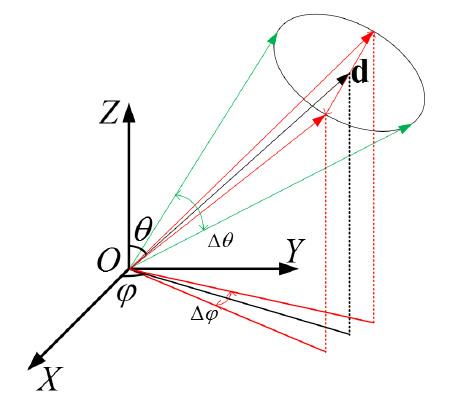
Figure 3. The variation of line direction with the fluctuation of θ and φ . The fluctuation ∆ θ is added to θ and ∆ φ is added to φ . The cone indicates the fluctuation of direction with ∆ θ and ∆ φ .